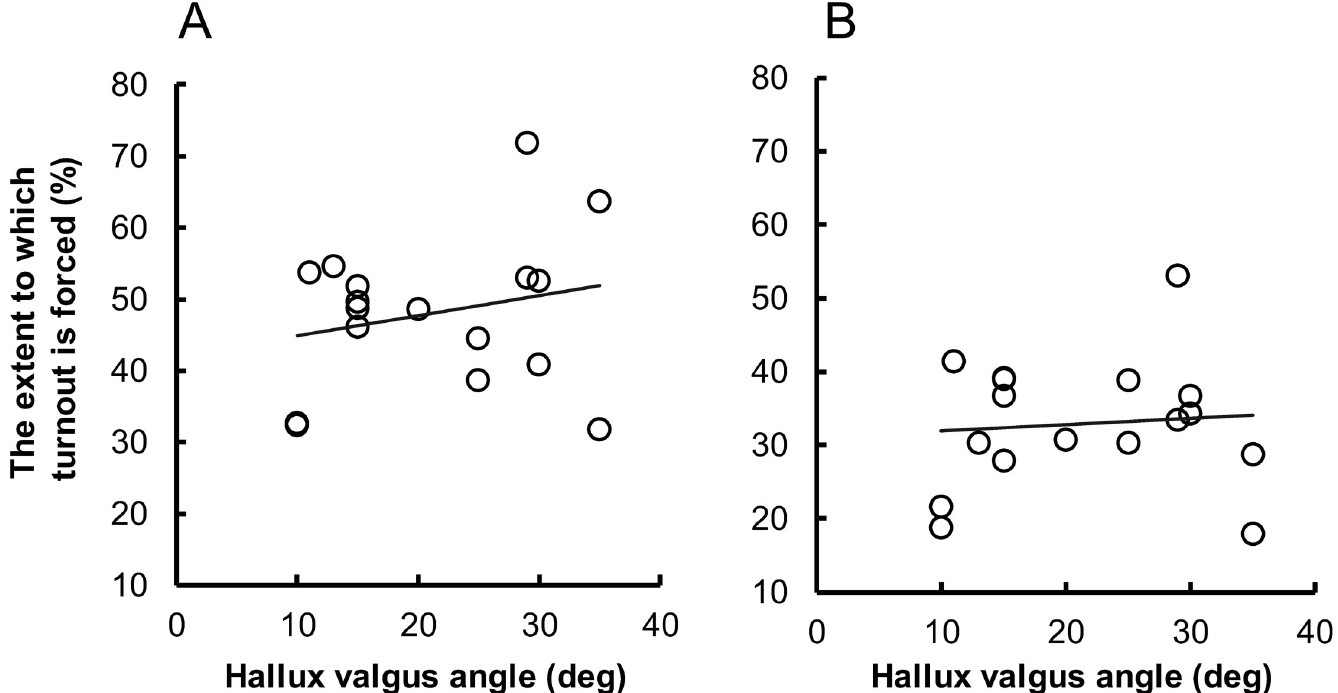
Fig 2. The scatter plots of the hallux valgus angle versus the extent to which the turnout is forced. During (A) standing and (B) plie´ in the first position. The extent to which the turnout is forced is measured by the below-hip contributors (i.e., the percentage of sum of external rotation angle of knee and ankle relative to the total turnout